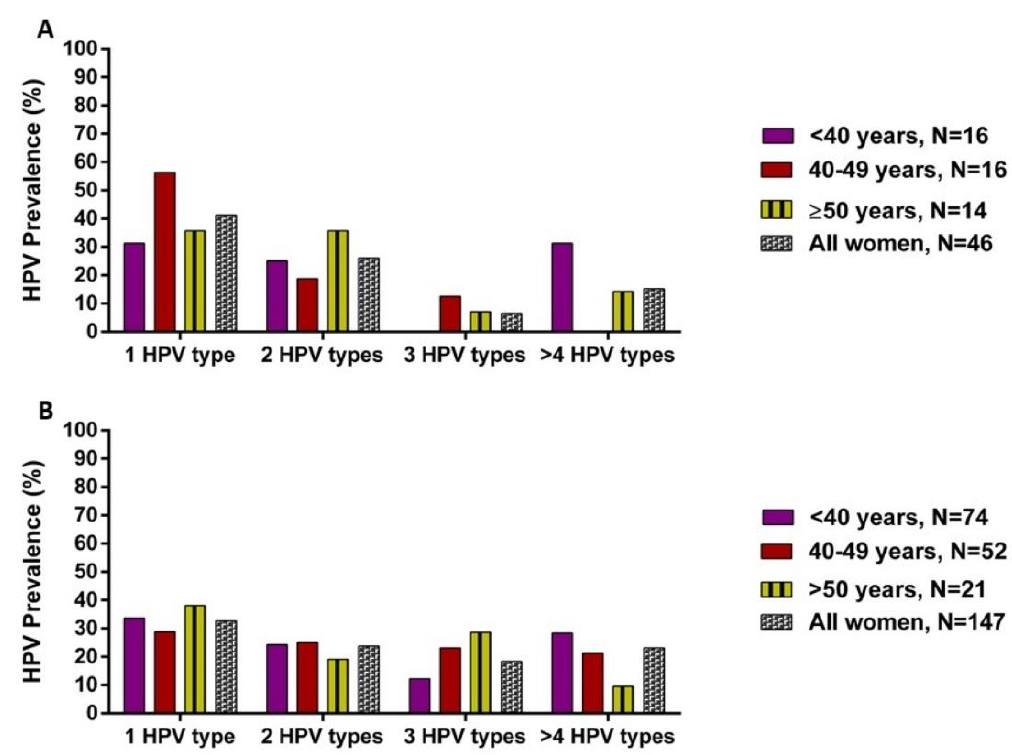
Figure 1. Distribution of single and multiple HPV types according to age in HIV-negative ( A ) and HIV-positive ( B ) women with cervical intraepithelial lesions.